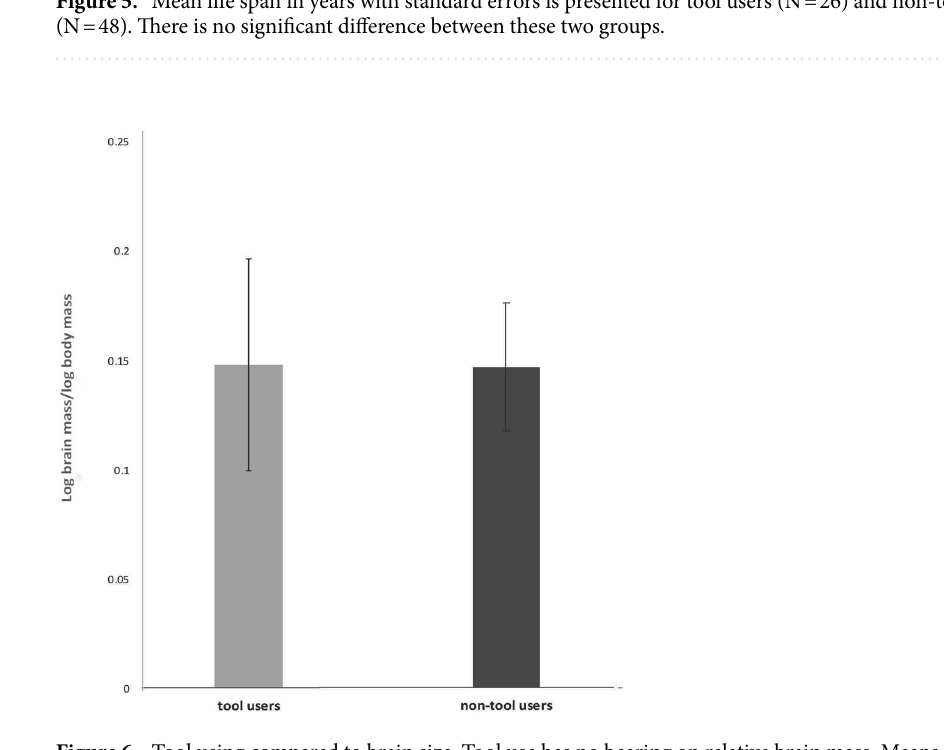
Figure 6. Tool using compared to brain size. Tool use has no bearing on relative brain mass. Means with standard errors are